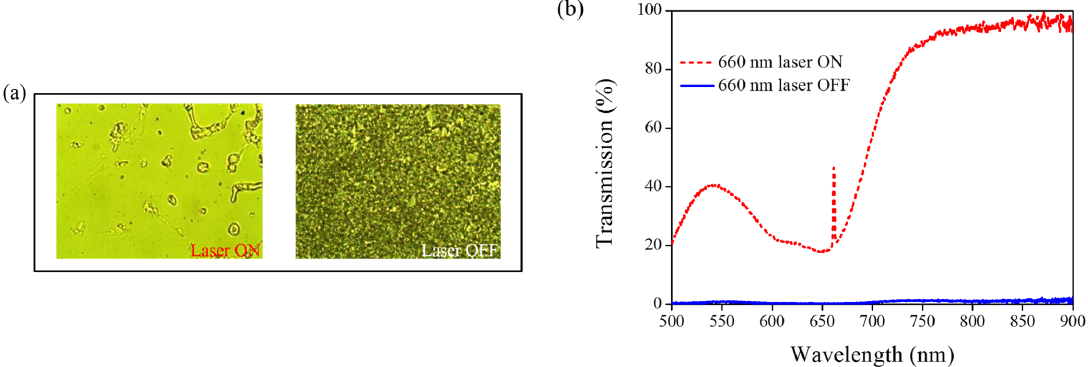
Figure 7. ( a ) POM images (picture area: 270 μ m × 320 μ m) and ( b ) transmission spectra of AQ dye-doped CLC containing A4 molecules (3 wt% AQ dye, 15 wt% A4, 20 wt% S811 and 62 wt% MDA3461) under different conditions of 660-nm wavelength laser exposure.